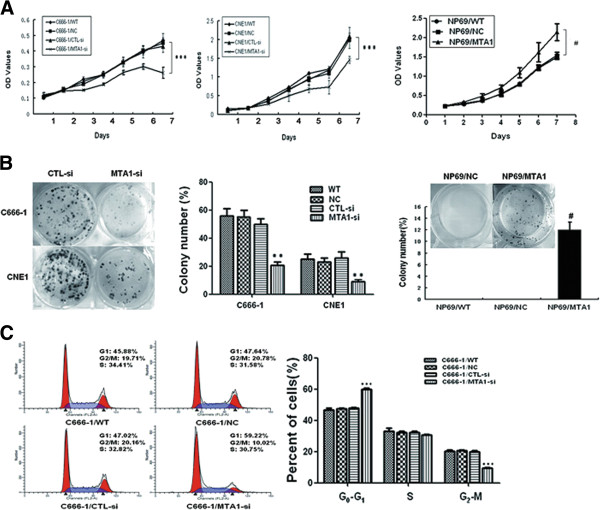
MTA1 promotes the growth of NPC cells in vitro. (A) MTT proliferation assay of MTA1 knockdown cell lines, MTA1 overexpression cell lines and control cells. (B) Representative images of colony formation assay of MTA1 knockdown cell lines, MTA1 overexpression cell lines and control cells. (C) Flow cytometry analysis of cell-cycle distribution of MTA1 knockdown C666-1 cells and control cells. All results were reproducible in three independent experiments. CTL-si versus WT: P > 0.05; **P < 0.01, ***P < 0.001 compared to CTL-si. # P < 0.001 compared to NC. OD, optical density.